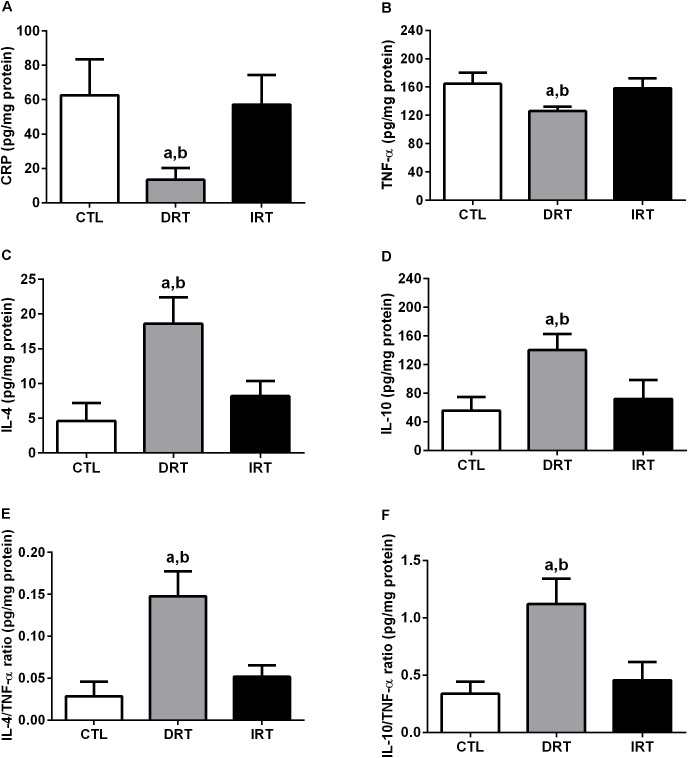
Muscular inflammatory states. Data are presented as mean ± SD. C-reactive protein (A), tumor necrosis factor alpha (B), interleukin-4 (C), interleukin-10 (D), interleukin-4/tumor necrosis factor alpha ratio (E) and interleukin-10/tumor necrosis factor alpha ratio (F). CTL, control group; DRT, dynamic resistance training; IRT, isometric resistance training; CRP, c-reactive protein; TNF-α: tumor necrosis factor alpha; IL-4, interleukin-4; IL-10, interleukin-10. The one-way ANOVA followed by the Tukey’s post-hoc test was adopted to verify the difference between the groups. ap < 0.0001 vs. CTL group (between groups); bp < 0.0001 vs. IRT group (between groups), (n = 5 rats per group).